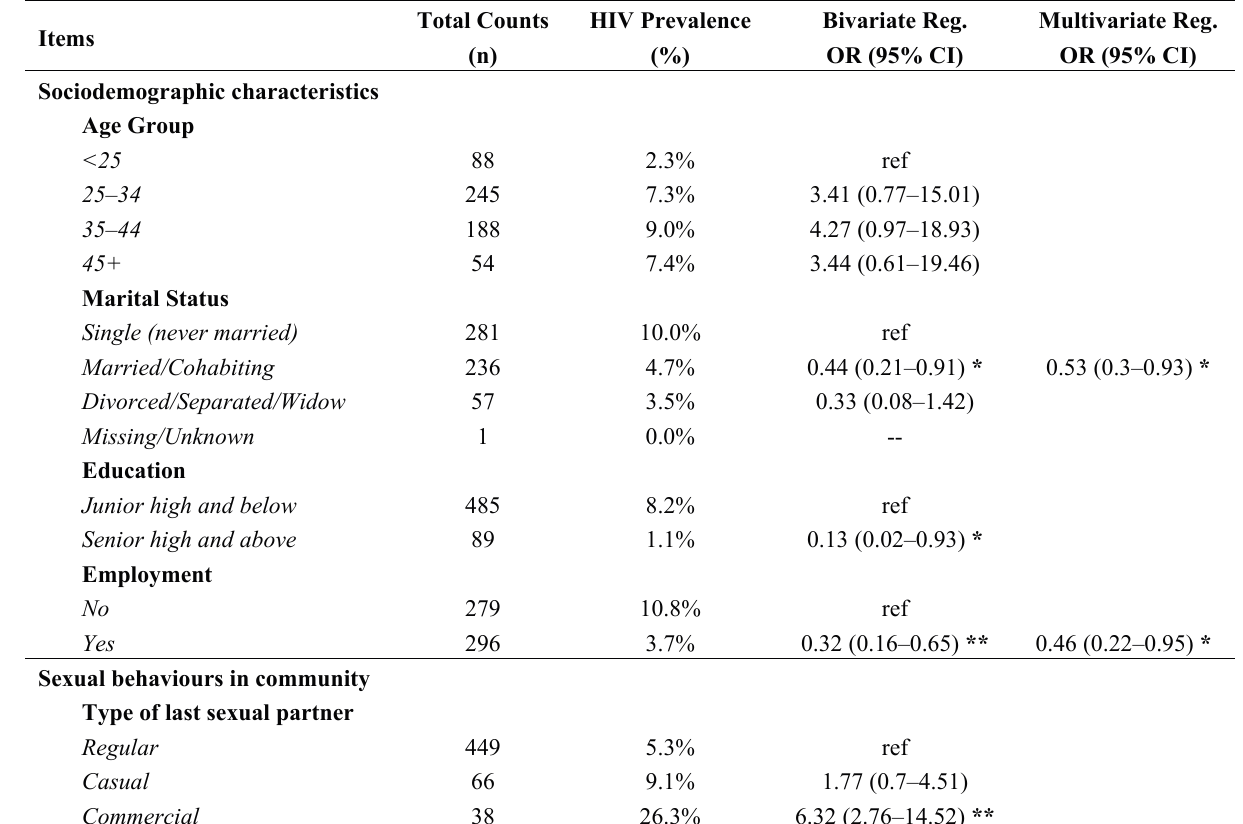
Table 3. Self-reported HIV prevalence and associated factors among male detainees in